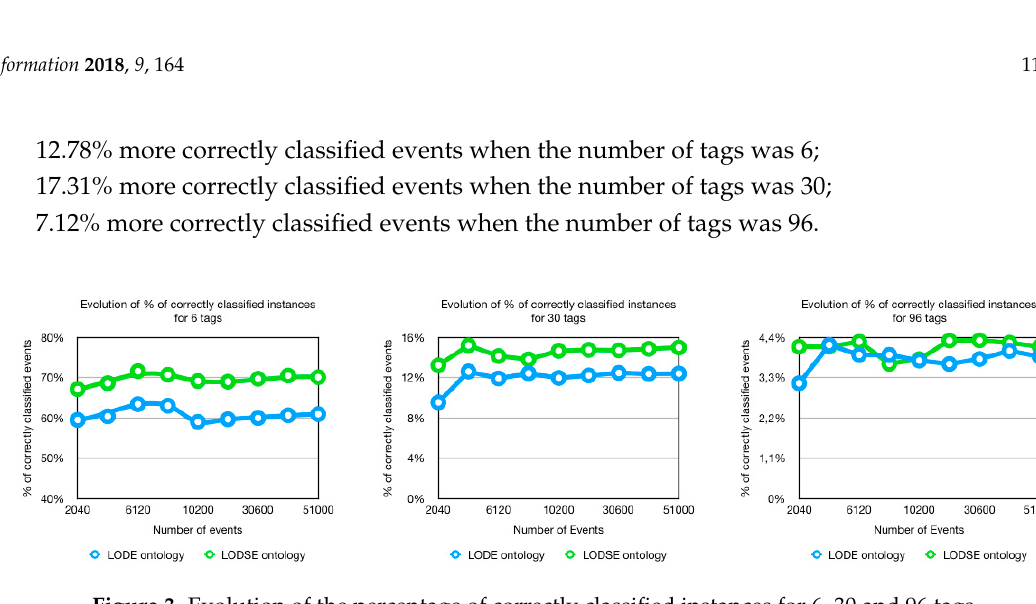
Figure 3. Evolution of the percentage of correctly classified instances for 6, 30 and 96 tags.